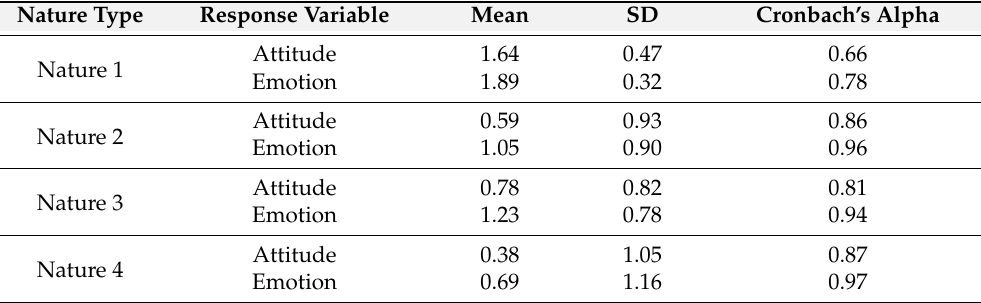
Table 3. Respondents’ attitudes and emotions towards urban forests representing four nature types (Table 1, Figure 1). Shown are mean values, standard deviation and reliability (Cronbach ´ s alpha) for each nature